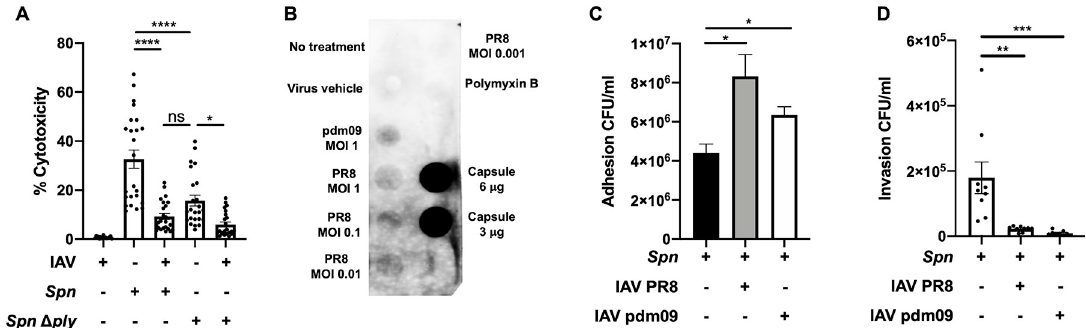
Fig 5. Influenza influences Spn- induced cytotoxicity and adhesion and promotes capsule shedding. ( A ) Spn alone is significantly more toxic to A549 cells than Spn incubated with IAV, or mutant Spn Δ ply , as measured by LDH cytotoxicity assay. IAV continues to synergize with Δ ply to further reduce toxicity. Data reflects n = 24 shown as mean ± SEM analyzed by one-way ANOVA ( � p < 0.05, ���� p < 0.0001). ( B ) Dot blot of concentrated conditioned media from Spn with or without IAV challenge using two viral strains, PR8 and H1N1 A/California/7/2009 (pdm09). IAV challenge induced capsule release into media in a dose-dependent manner. Both IAV strains induced Spn to increase adhesion ( C ) and decrease invasion ( D ) of A549 cells. Data in ( C ) and ( D ) represent n = 9 presented as mean ± SEM analyzed by Kruskal-Wallis test with Dunn’s multiple-comparison post-test. Asterisks denote the level of significance observed: � = p � 0.05; �� = p � 0.01; ��� = p � 0.001.